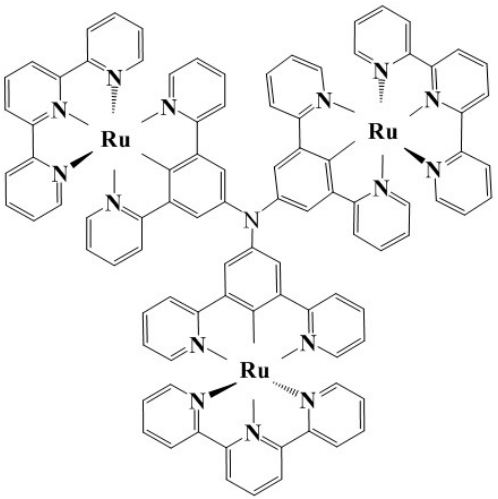
Figure 1. Schematic chemical configuration of triruthenium complex with a triarylamine core.